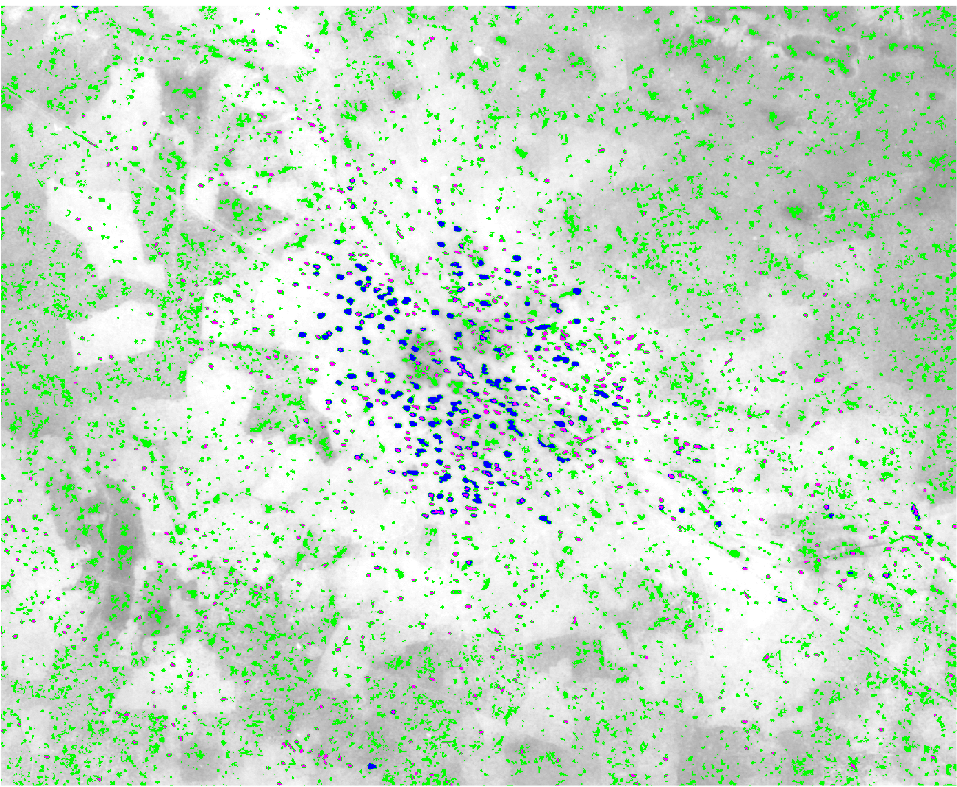
Figure 7. Classification in 4 classes from 12 granulometric levels. Guileyni, 1975.